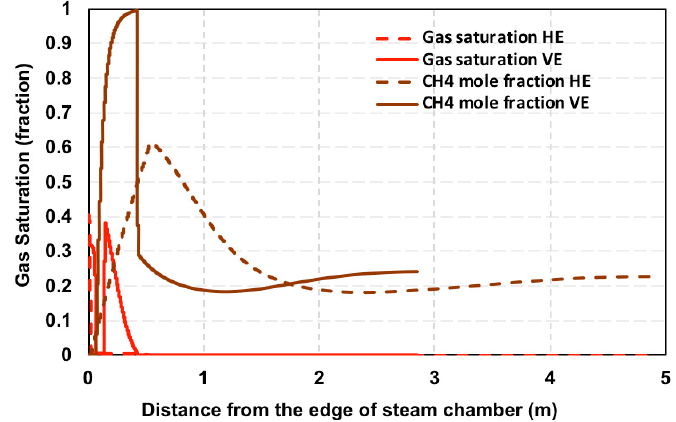
Figure 5. Gas saturation profile and gas mole fraction of methane, i.e., fraction of solution gas ex-solved into the gas phase versus distance for the VE and HE models.